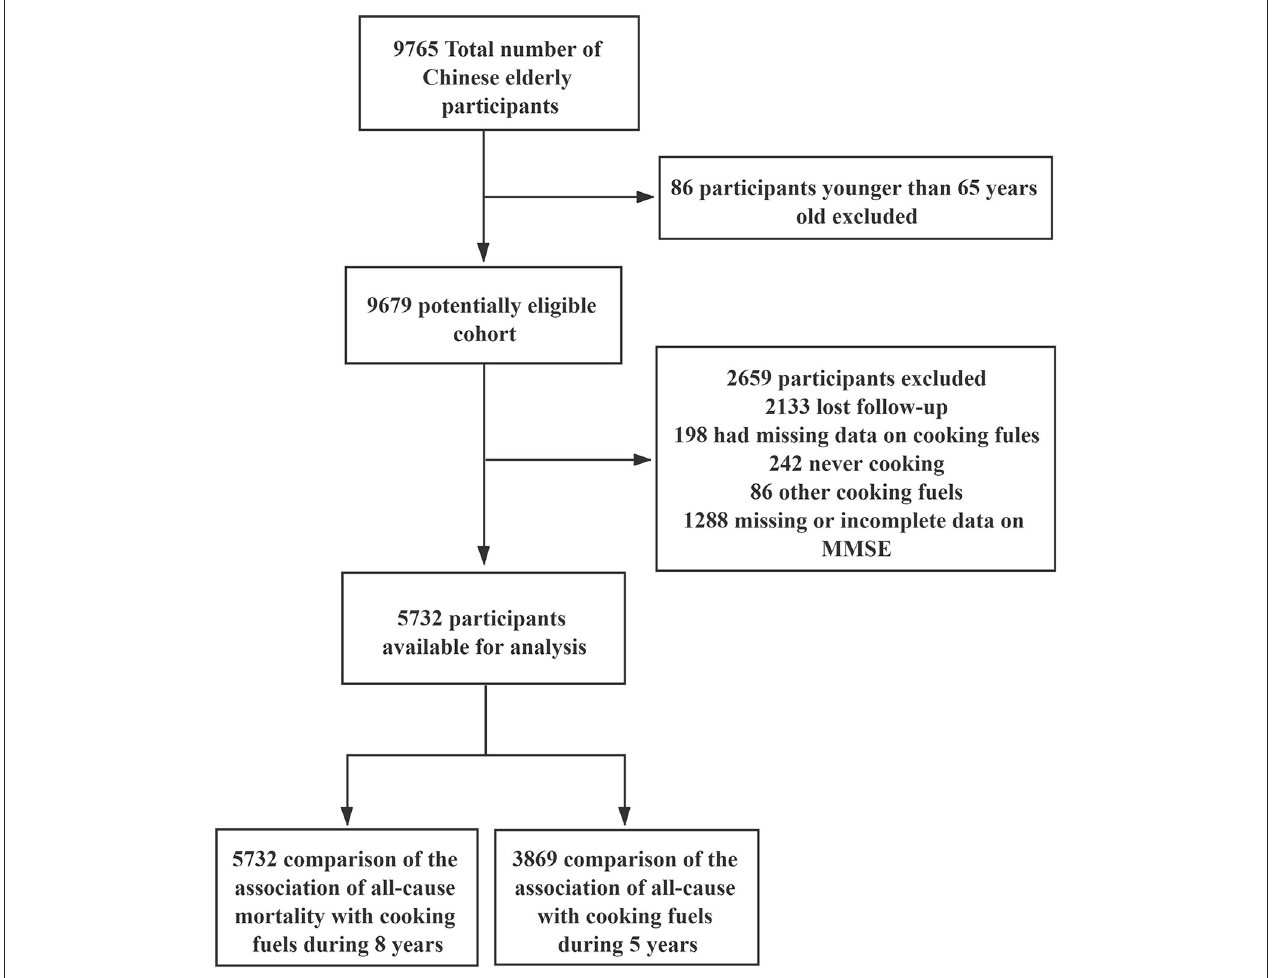
FIGURE 1 | Flowchart of the inclusion of